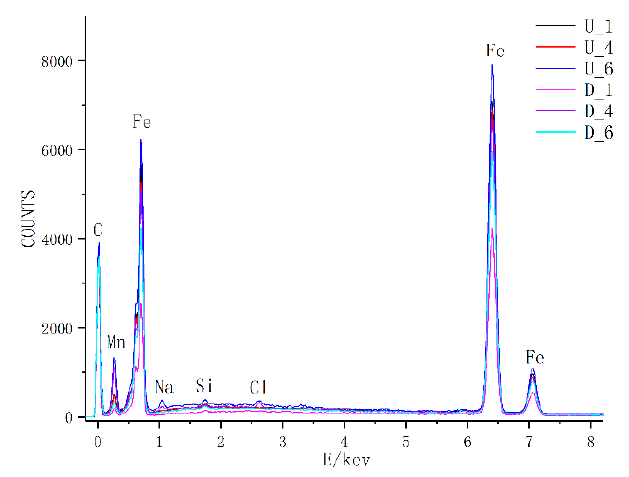
Figure 12. Results of energy spectrum analysis at a set of fixed measurement points.